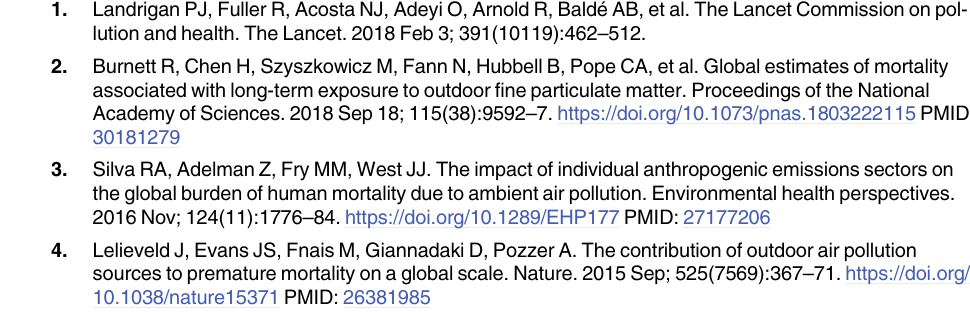
S10 Fig. Comparison between Global and US InMAP. Changes in Total PM tions from road vehicle emissions and from power generation emissions as predicted by Global InMAP (which has GEOS-Chem preprocessor inputs) alongside US InMAP (which has WRF-Chem preprocessor inputs).